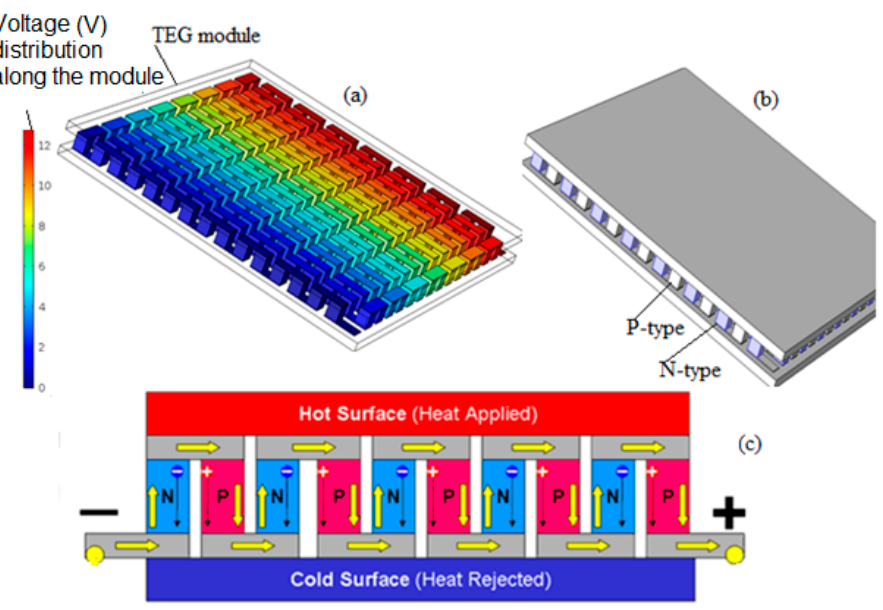
Figure 1. Principle of operation of a thermoelectric generator: part ( c ) is modified from [22].